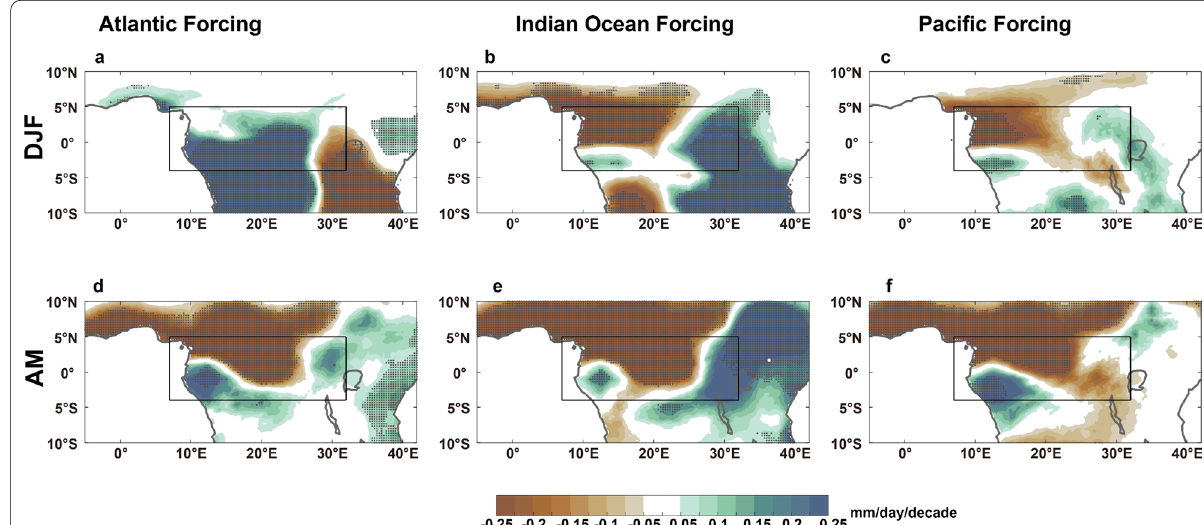
Fig. 6 Simulated seasonal precipitation change from 1979 to 2015 in atmospheric models. Color mapping represents the precipitation change (increase, dark green; decrease, dark brown). Dark dots indicate that precipitation trends are significant at the 5% level. a – c show the precipitation change during the boreal winter dry season (DJF) forced by the tropical Atlantic, Indian Ocean and Pacific SST. e – g same as a – c but for the boreal spring wet season